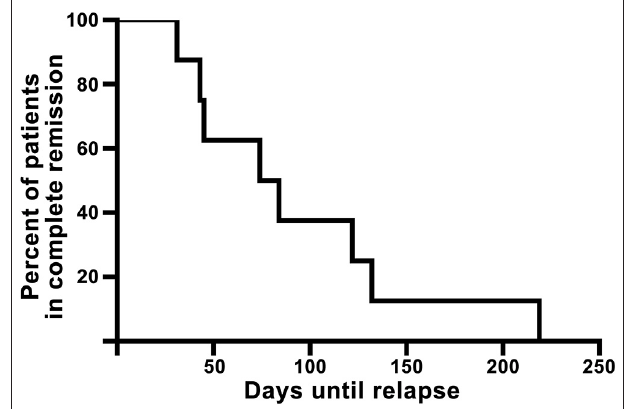
FIGURE 2 | Kaplan-Meier curve of the eight full responders showing time from end of treatment until reappearance of visible psoriasis (visit X).